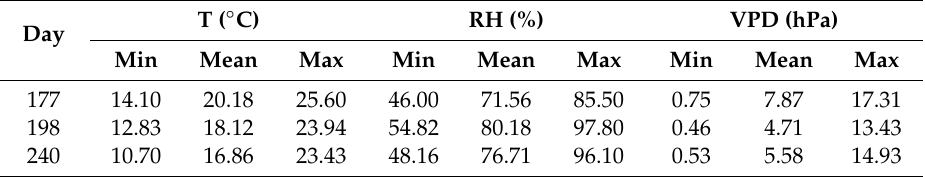
Table 1. Environmental conditions during the sampling days (177: 26 June; 198: 17 July; 240: 28 August) in summer 2018. Precipitation is the sum of all events during the season. Minimum, mean and maximum daily temperature (T ◦ C), relative humidity (RH%) and vapor pressure deficit of the atmosphere